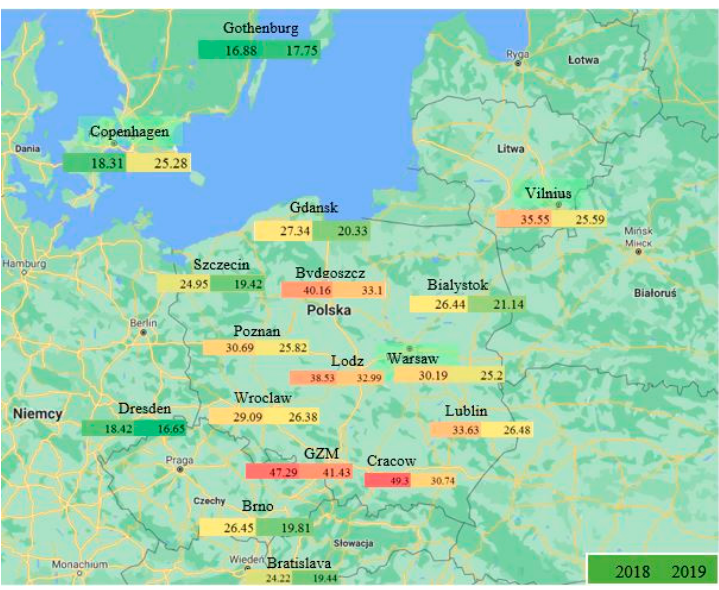
Figure 8. Average PM10 concentration in Polish and neighboring countries in 2018 and 2019, own study based on [13].